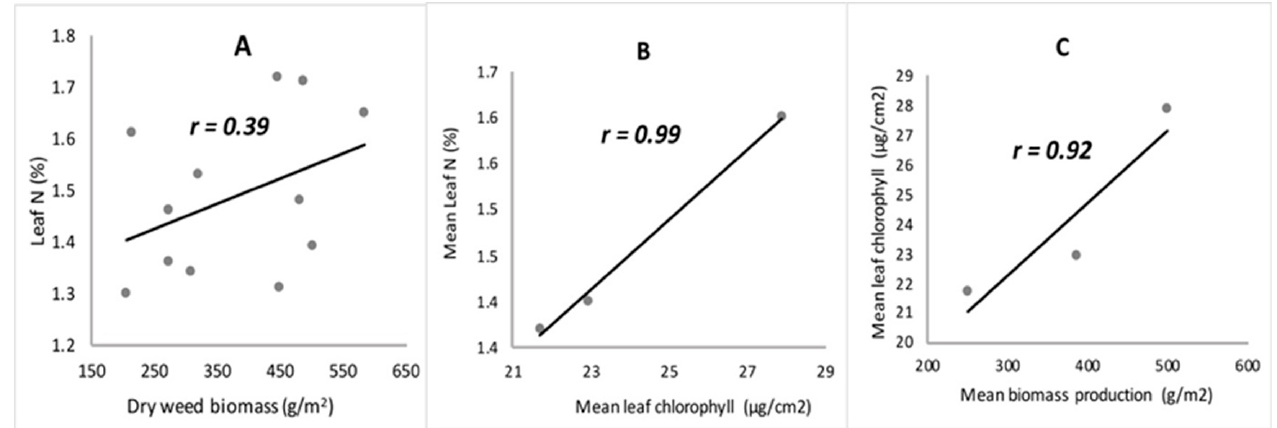
Figure 3. Correlation between leaf N and dry biomass (weed + mulching species) ( A ), between leaf N and leaf chlorophyll ( B ), and between leaf chlorophyll and dry biomass production ( C ).